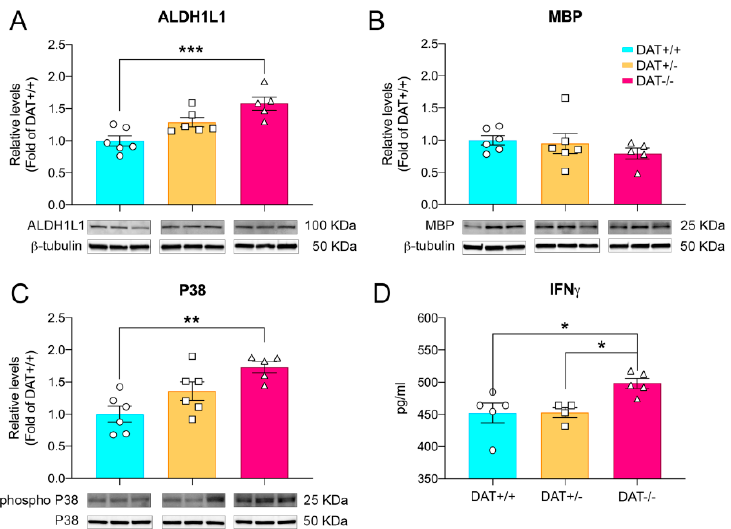
Figure 4. Increase in markers of neuroinflammation in DAT − / − rats. ( A ) DAT − / − rats showed an increase in levels of astroglial marker ALDH1L1. ( B ) Levels of myelin basic protein were unchanged among the three genotypes. ( C ) Phosphorylation levels of MAPKp38 were significantly increased in the PFC of DAT − / − rats. ( D ) ELISA analysis displayed an increase in the PFC tissue levels of IFN γ inflammatory cytokine of DAT − / − rats (myelin basic protein—MBP). Individual data points are shown for each group. Data are presented as mean ± SEM, * p < 0.05, ** p < 0.01, *** p < 0.001.